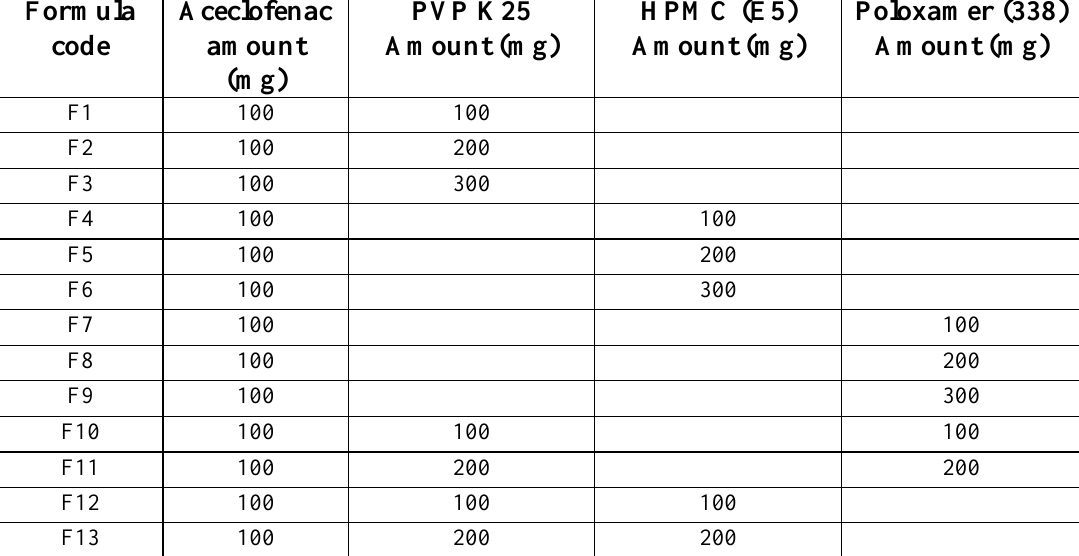
Table 1. Compositions of AC NS.s formulas using different stabilizers at different drug: stabilizer ratios with constant volume of injected organic solution (2